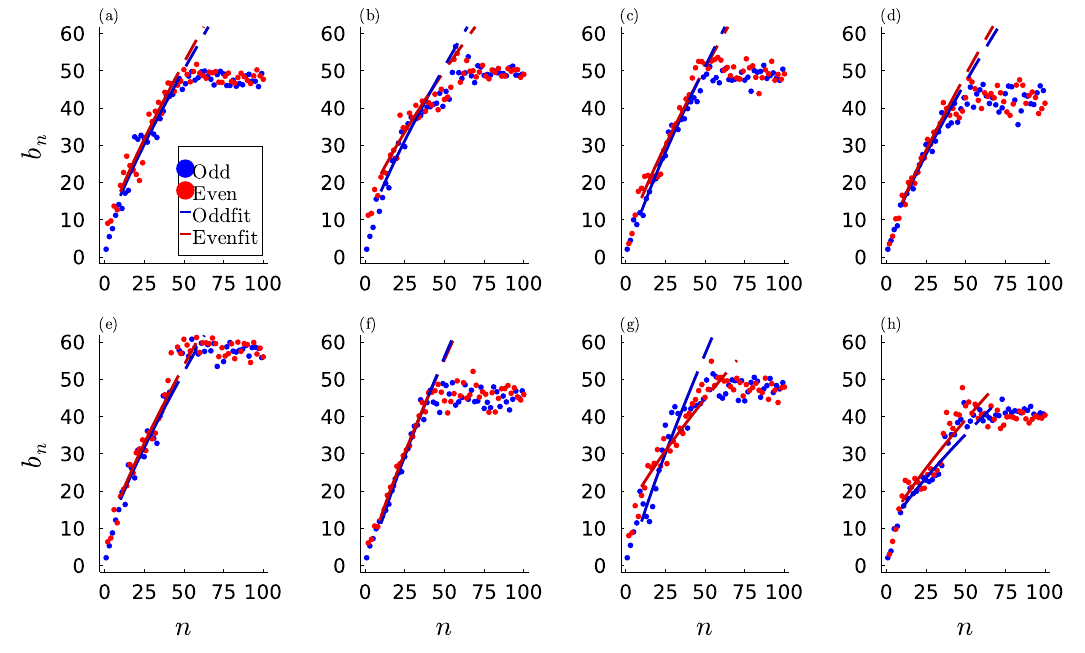
Figure 2: (a)-(h) The disorder realizations of b for Eq. (12) for h = 7 and L = 13, n with the initial operator Z . We use b in the range of n = 10 to n = 40 to fit the n 0 linear-extrapolation formula Eq. (13), and then use the fitted results to extrapolate b for n > 40 for each disorder n